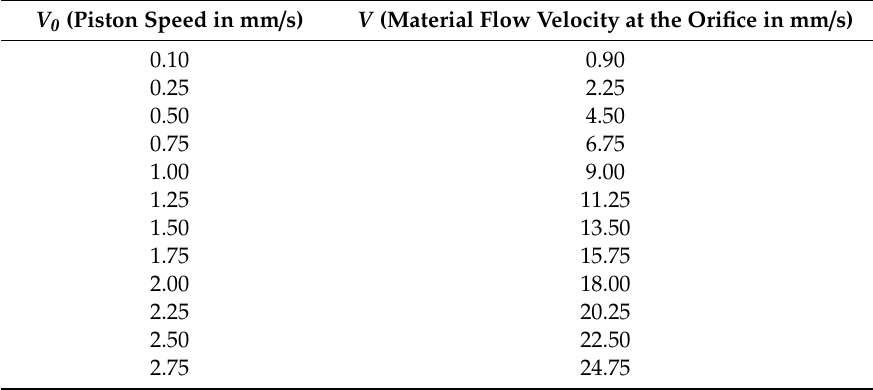
Figure 6. Predefined piston speeds and displacements for the test of extrusion pressure with different material flow velocities. Table 3. Piston moving velocity and material flow velocity at the orifice.